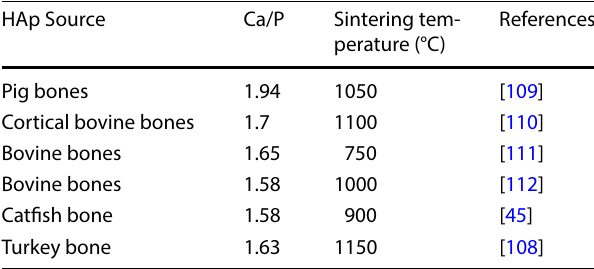
Table 8 Ca/P ratios of other studies HAp